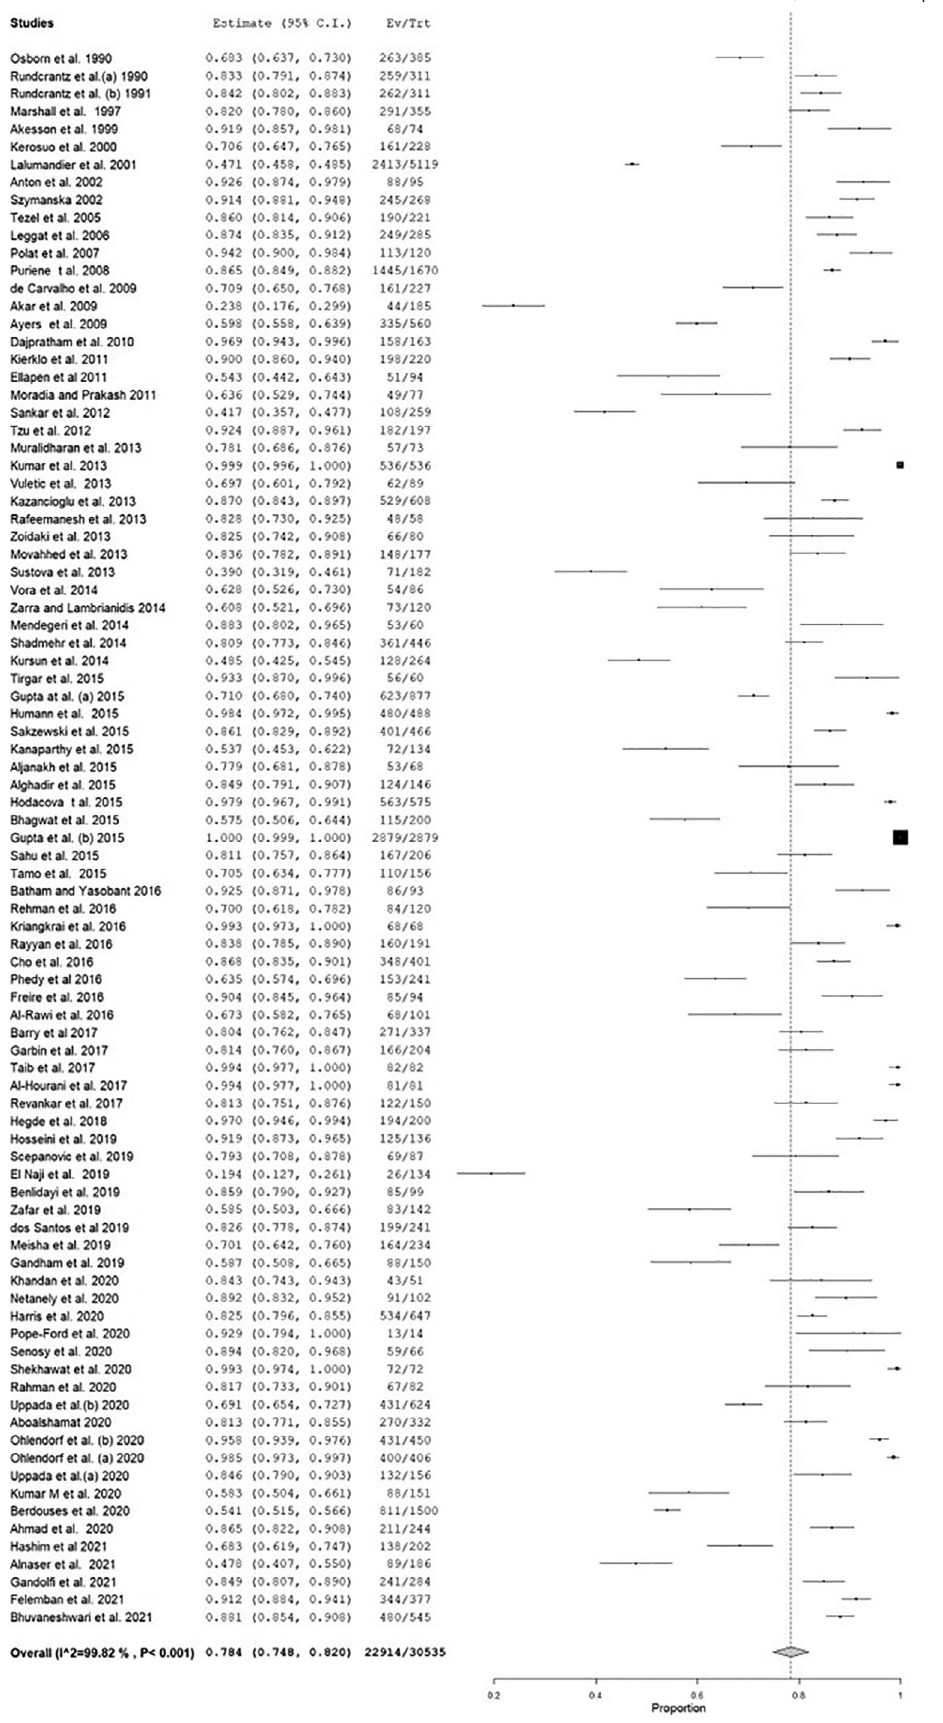
Figure 3. Forest plot of the prevalence of musculoskeletal disorders